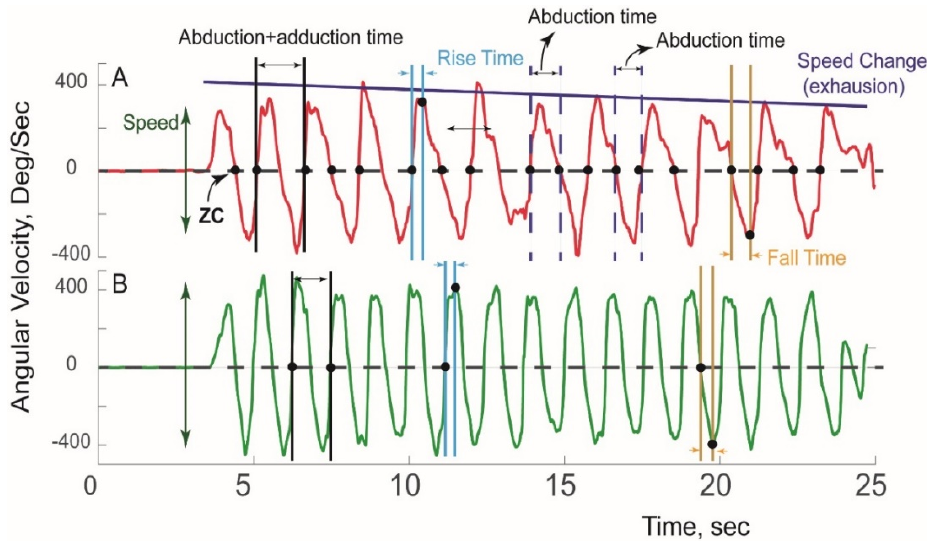
Figure 2. Sensor-derived assessment of extremity function. A typical pattern of angular velocity measured during a Press Test is shown for the ( A ) affected extremity and ( B ) unaffected extremity in a patient with unilateral nTOS.